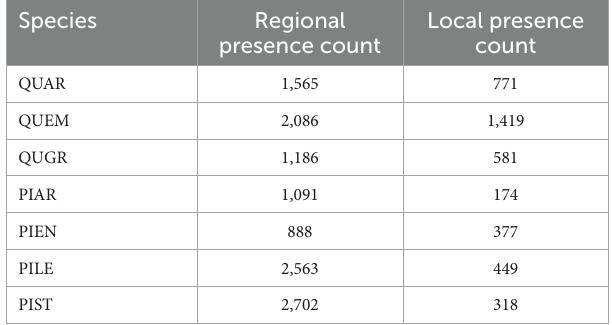
TABLE 3 Number of presence records used in both spatial modeling scales listed by